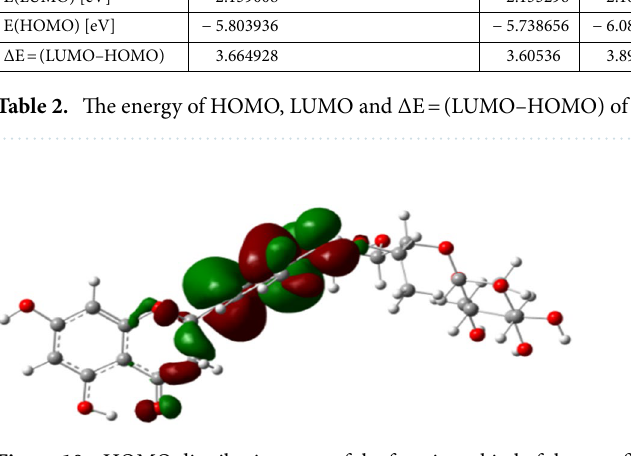
Figure 10. HOMO distribution map of the frontier orbital of the new flavonoid. Red color represents the positive part of the molecular orbital, while the green color represents the negative